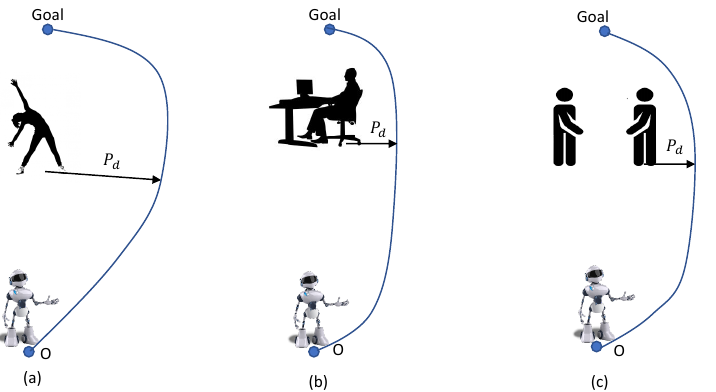
Figure 1. Robot approaching a goal position while perceiving human actions and maintaining an appropriate distance with the person; ( a ): A person doing an exercise, ( b ): A person working on a laptop, and, ( c ): Two persons having a